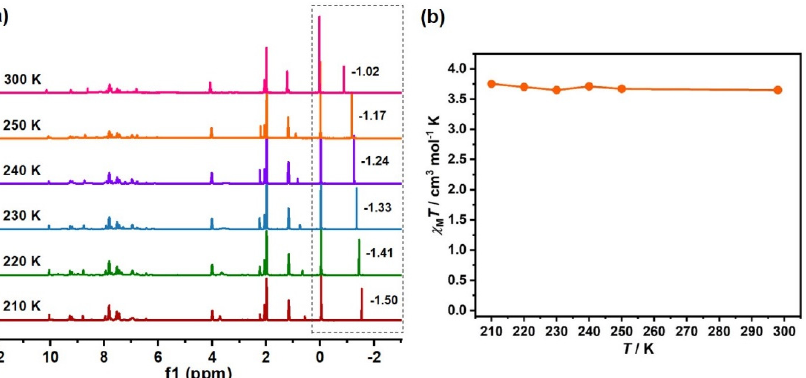
Figure 6. ( a ) 1 H NMR spectra for 1 , using variable Evans method in the temperature range of 300–210 K. ( b ) Calculated χ M T vs. T plot for 1 in the temperature range of 210–300 K.